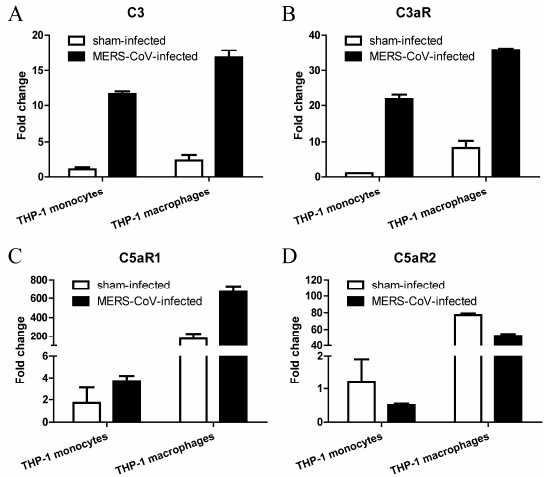
Figure 4. MERS-CoV infection alters complement expression in monocytes and macrophages. ( A – D ) Transcription of C3, C3aR, C5aR1, and C5aR2 in THP-1 monocytes and macrophages at 24 h post- MERS-CoV infection. Data are expressed as means ± SEM ( n = 2 per group).